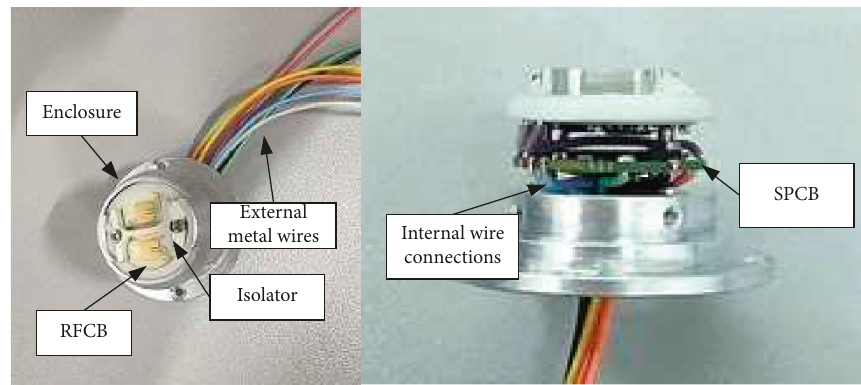
Figure 5: The structure of the millimeter wave detector.